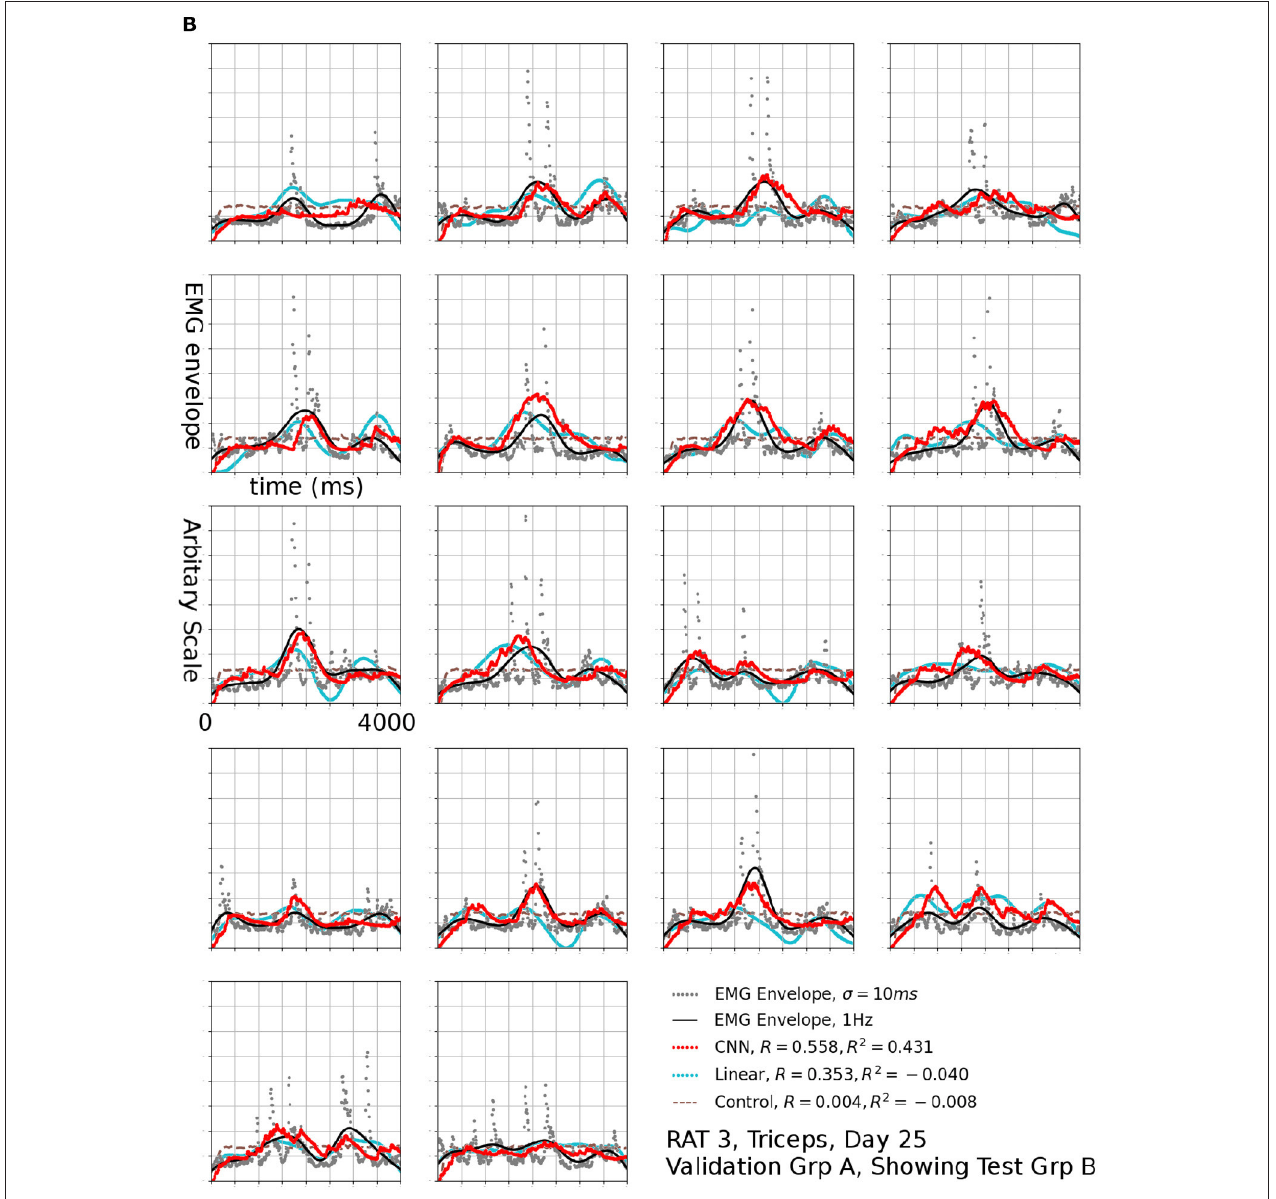
FIGURE 9 | Reconstruction of set (B) using set (A) as validation, the EMG signal is the same one shown in Figure 7a , filtered to 1Hz. The input to linear control were also filtered to